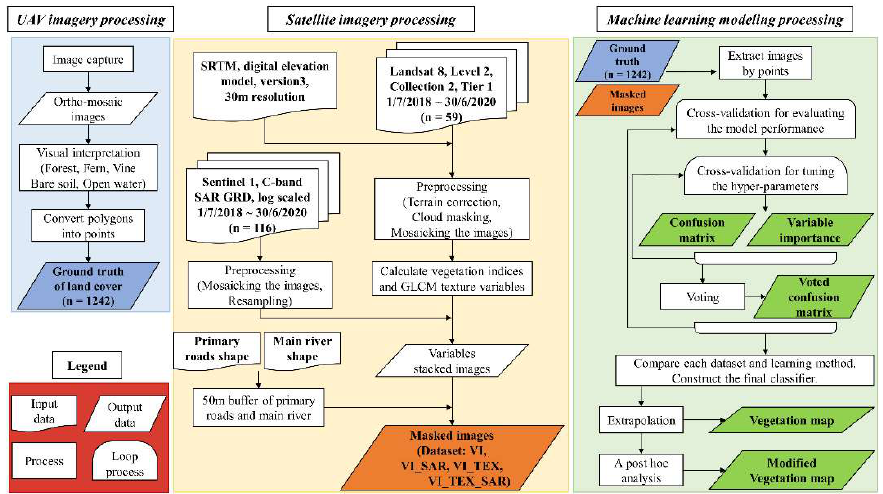
Figure 2. Flow chart of the vegetation classification and mapping algorithms in this study.